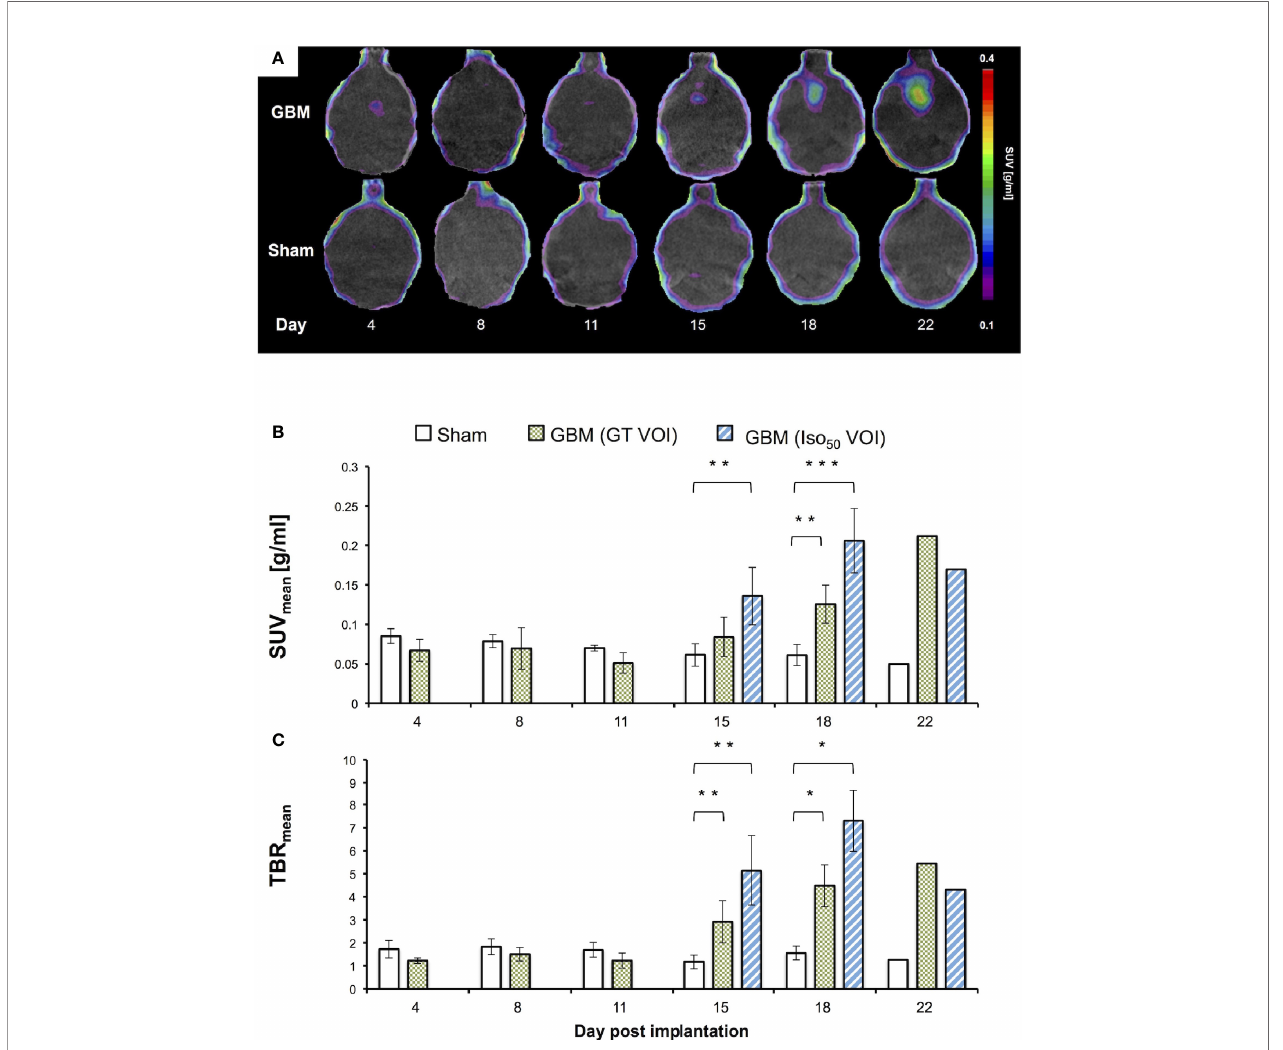
FIGURE 4 | Longitudinal 18 F-PSMA-1007 PET image fused on respective CT (A) , SUV mean (B) and TBR mean (C) . GT VOI, General tumor VOI. Day 4: (n = 5 GBM mice, n = 3 sham mice); day 8, 11 and 15: (all 8 GBM | 4 sham); day 18: (6 GBM | 3 sham); day 22 (1 GBM | 1 sham). *p < 0.05. **p < 0.01. ***p <